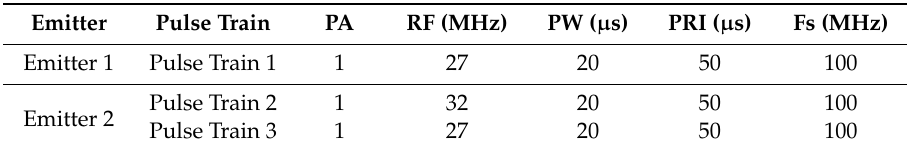
Table 4. Signal parameters of Experiment 1.